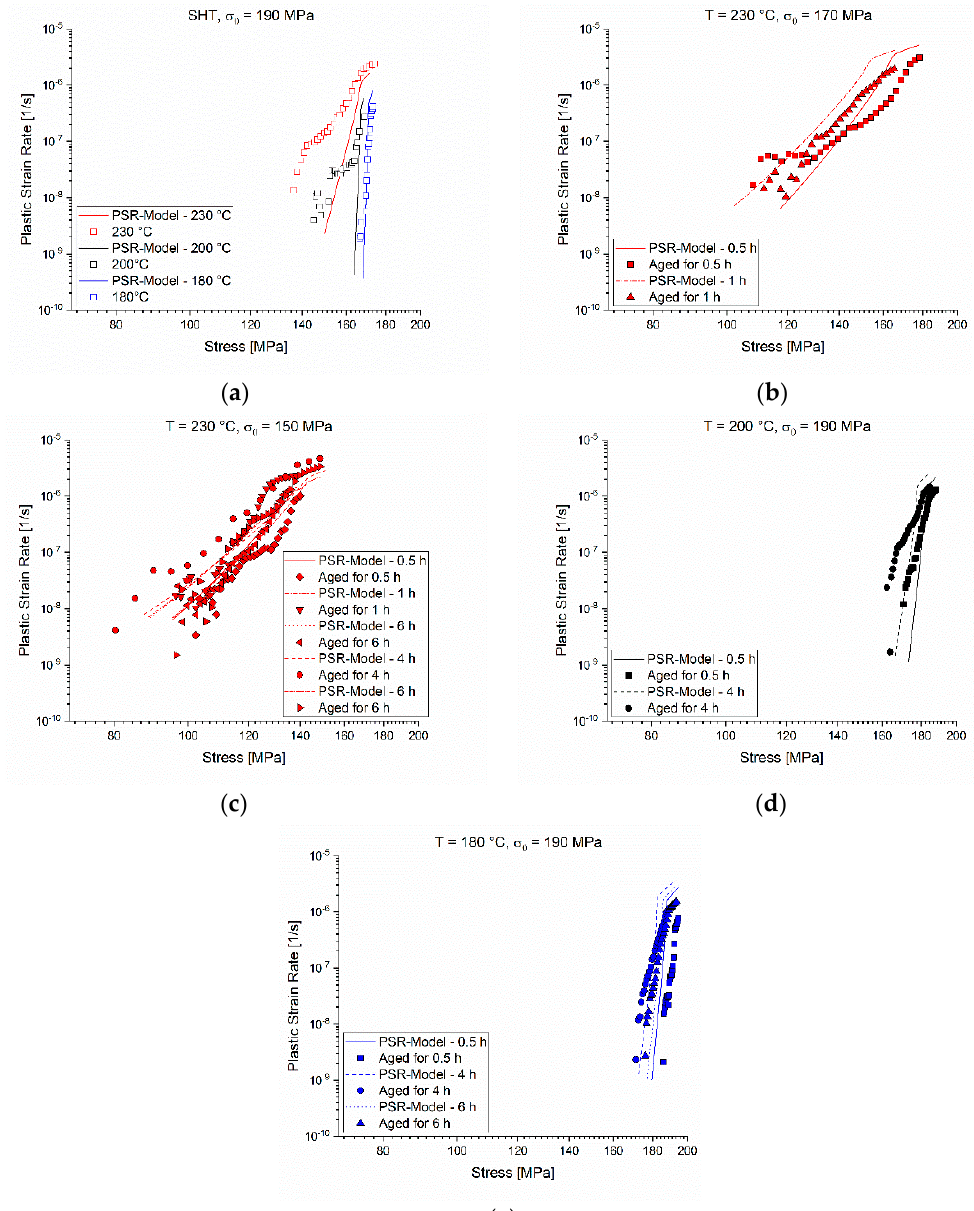
Figure 14. Comparison of the experimental and the simulated plastic strain rates (PSR) ( a ) after SHT condition and tested at 230 °C, 200 °C, 180 °C, and 190 MPa; ( b ) after ageing tested at 230 °C and 170 MPa; ( c ) at 230 °C and 150 MPa; ( d ) at 200 °C and 190 MPa; ( e ) at 180 °C and 190 MPa.